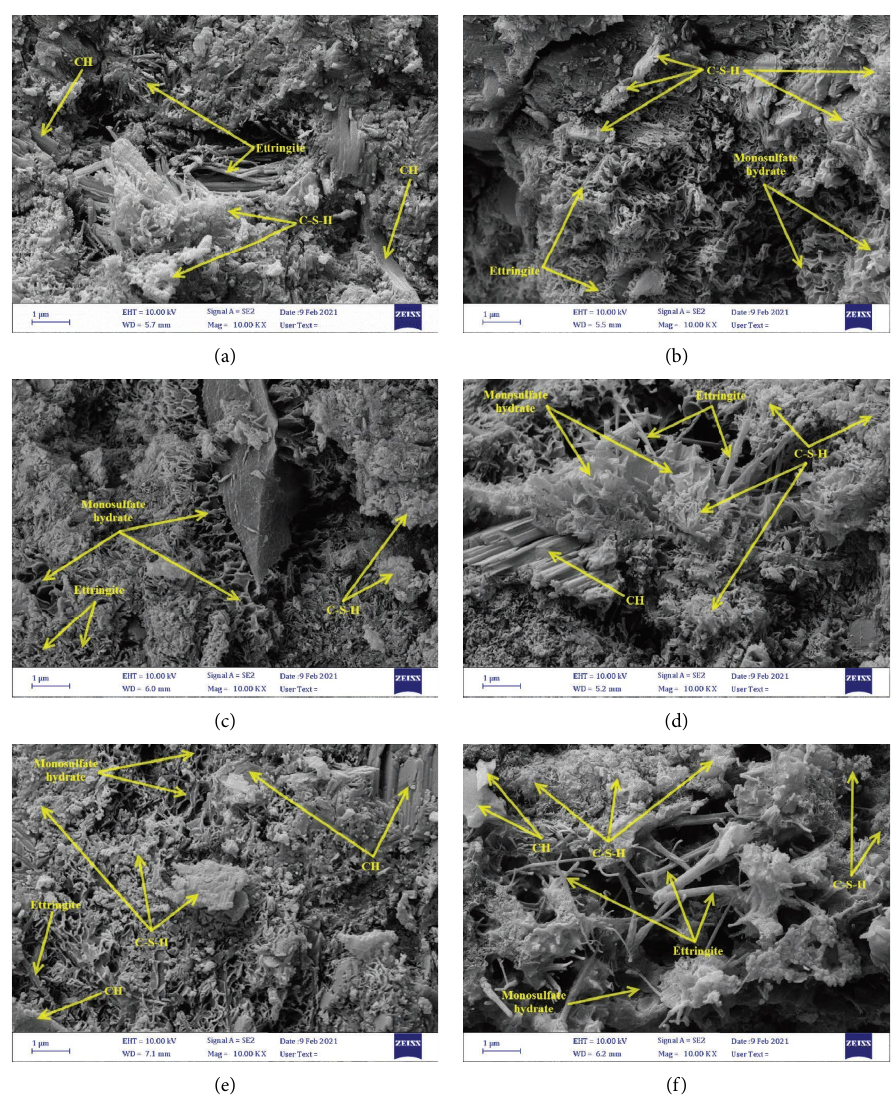
Figure 14: SEM images of the concrete specimens after 90 days of curing. (a) Ctrl. (b) SF5. (c) WGP15. (d) GGBFS15. (e) SF5 + WGP10. (f) SF5 +